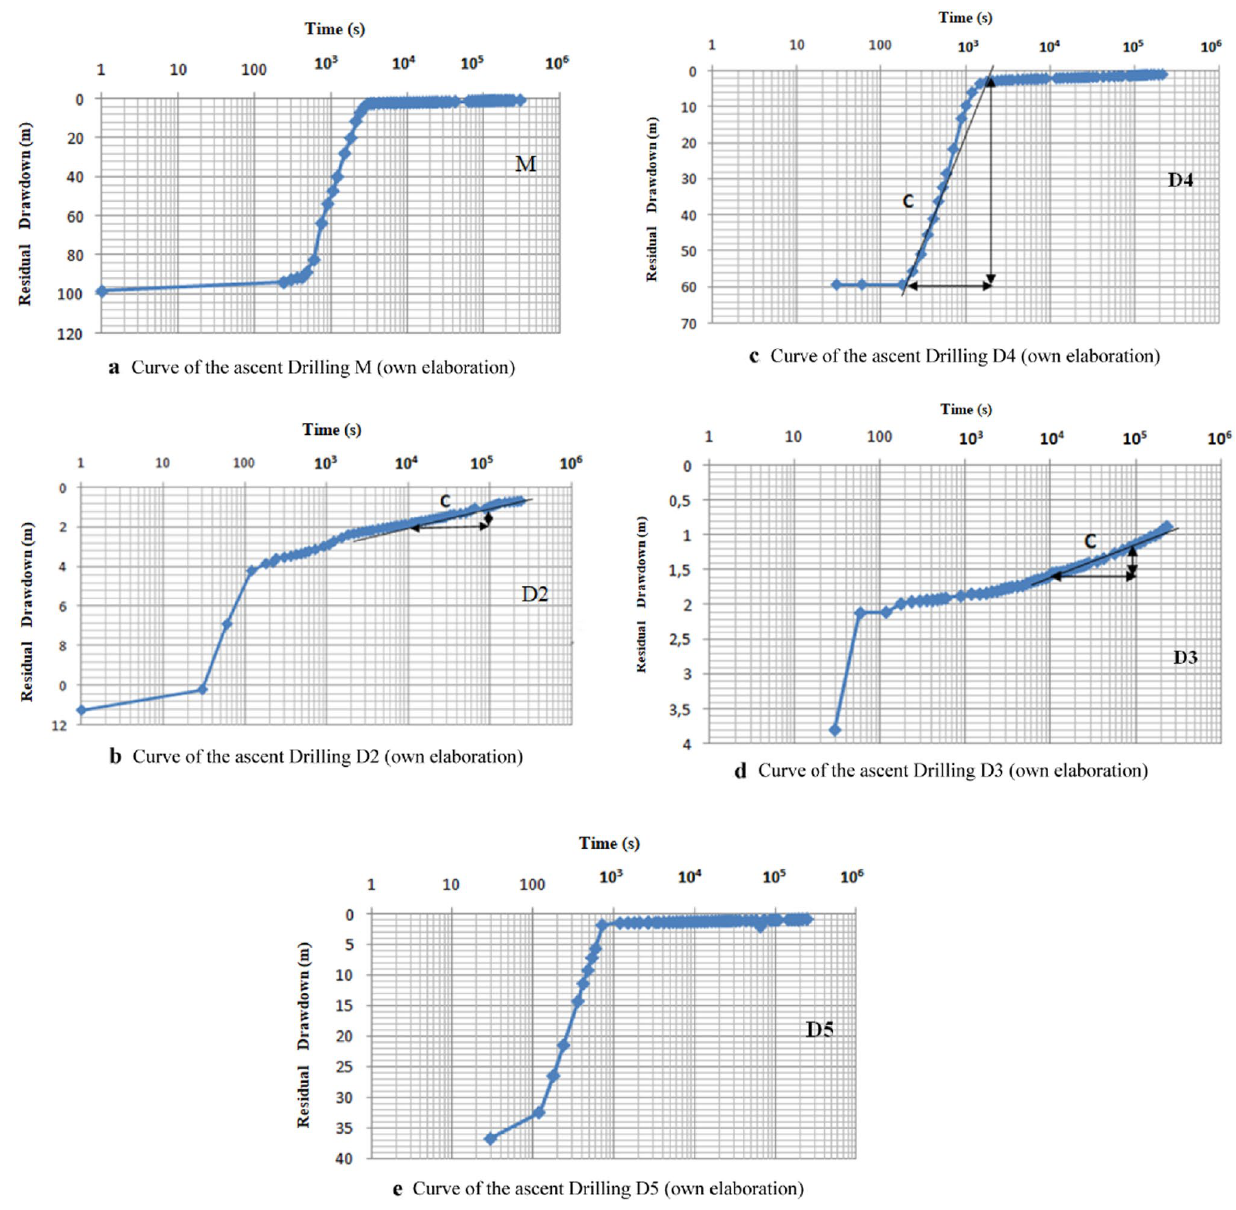
Fig. 7 a Curve of the ascent Drilling M (own elaboration), b Curve of the ascent Drilling D2 (own elaboration), c Curve of the ascent Drilling D4 (own elaboration), d Curve of the ascent Drilling D3 (own elaboration), e . Curve of the ascent Drilling D5 (own